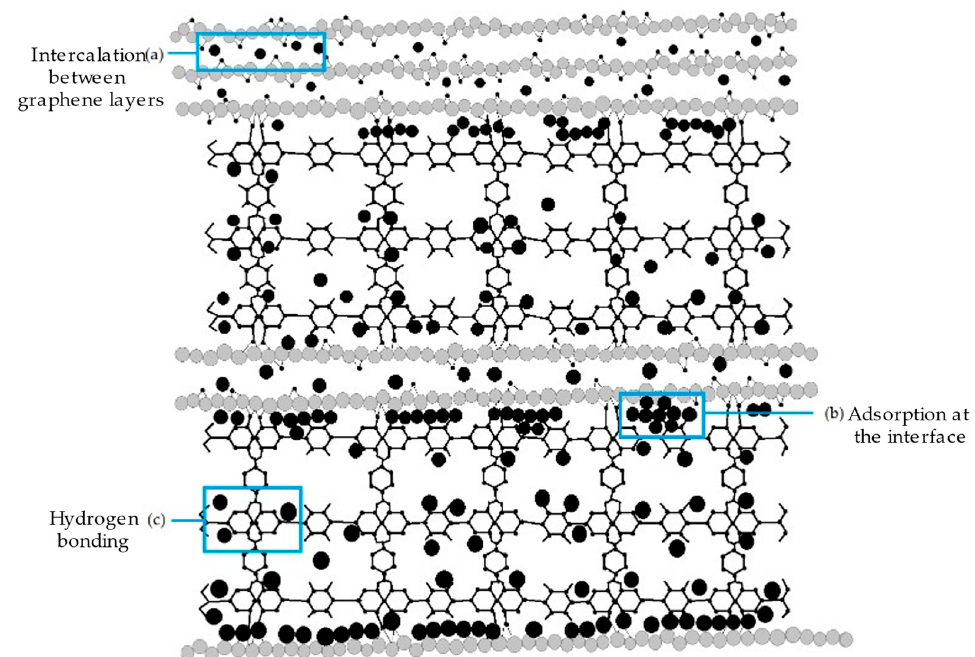
Figure 15. Schematic representation of the adsorption mechanism of NH 3 (black circle) in the composites, including ( a ) the intercalation between the graphene layers; ( b ) the adsorption at the interface between the graphene layers and the other segments; ( c ) hydrogen bonding with the oxygen atoms of metal oxides in the segments. Adapted with permission from [287]. Copyright ACS 2010.